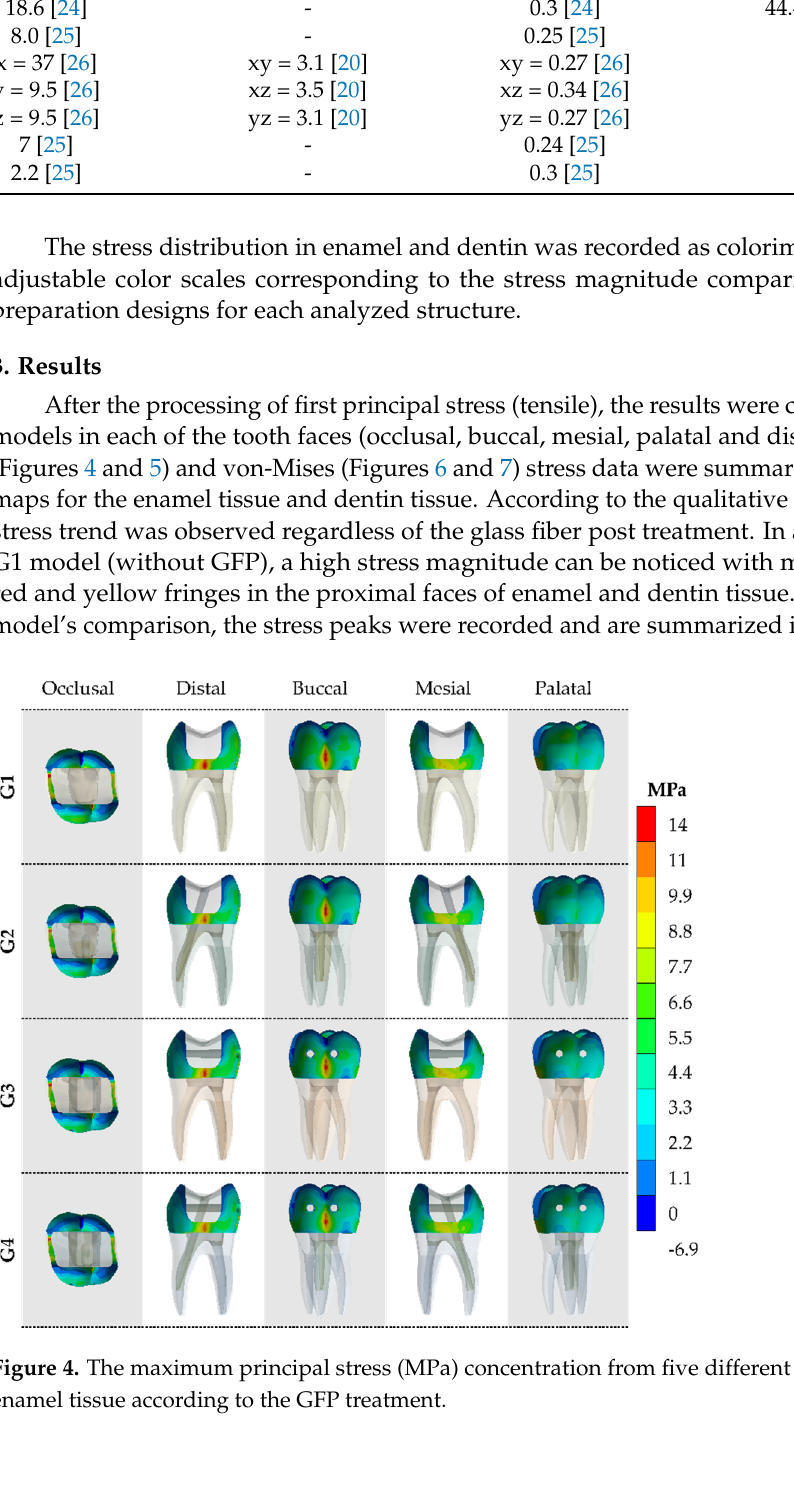
Figure 5. The maximum principal stress (MPa) concentration from five different viewpoints in the dentin tissue according to the GFP treatment.